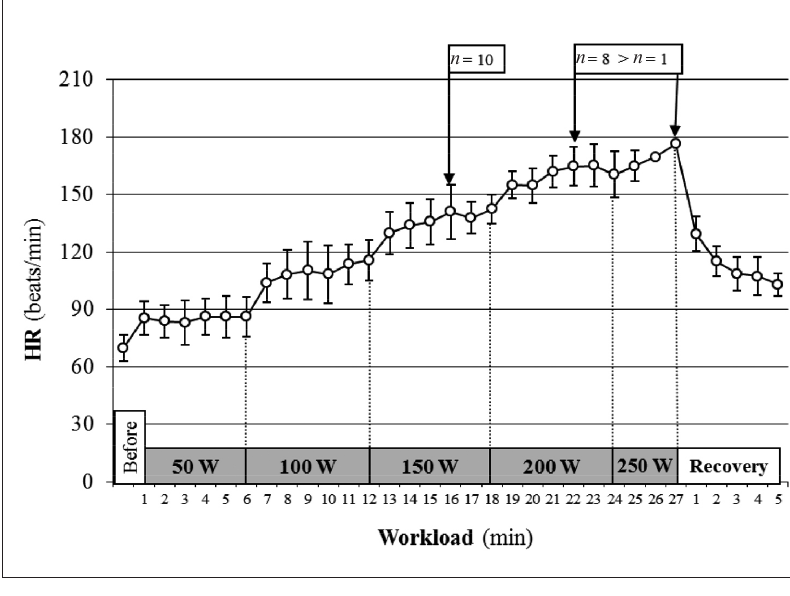
Figure 2. Dynamics of HR during incremental exercise test and recovery